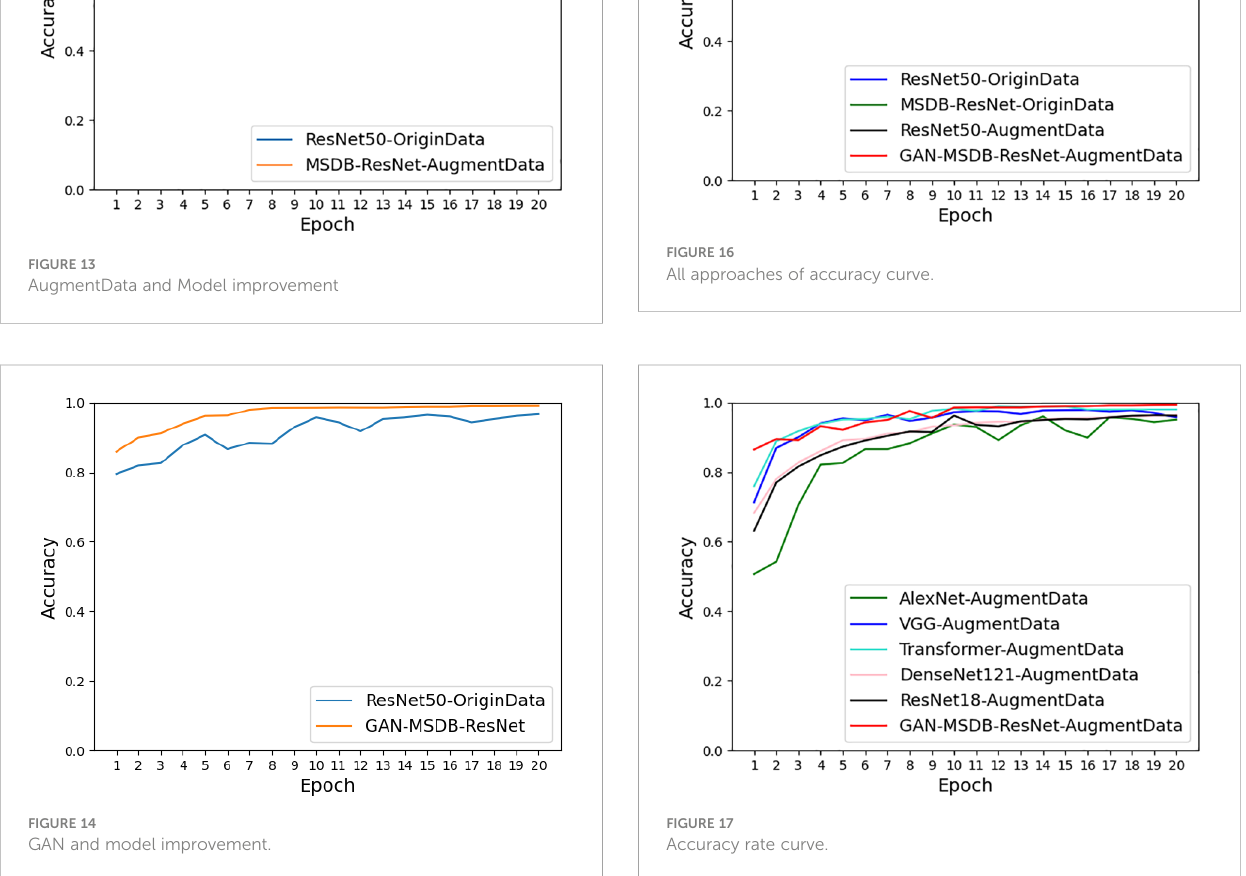
FIGURE 17 Accuracy rate